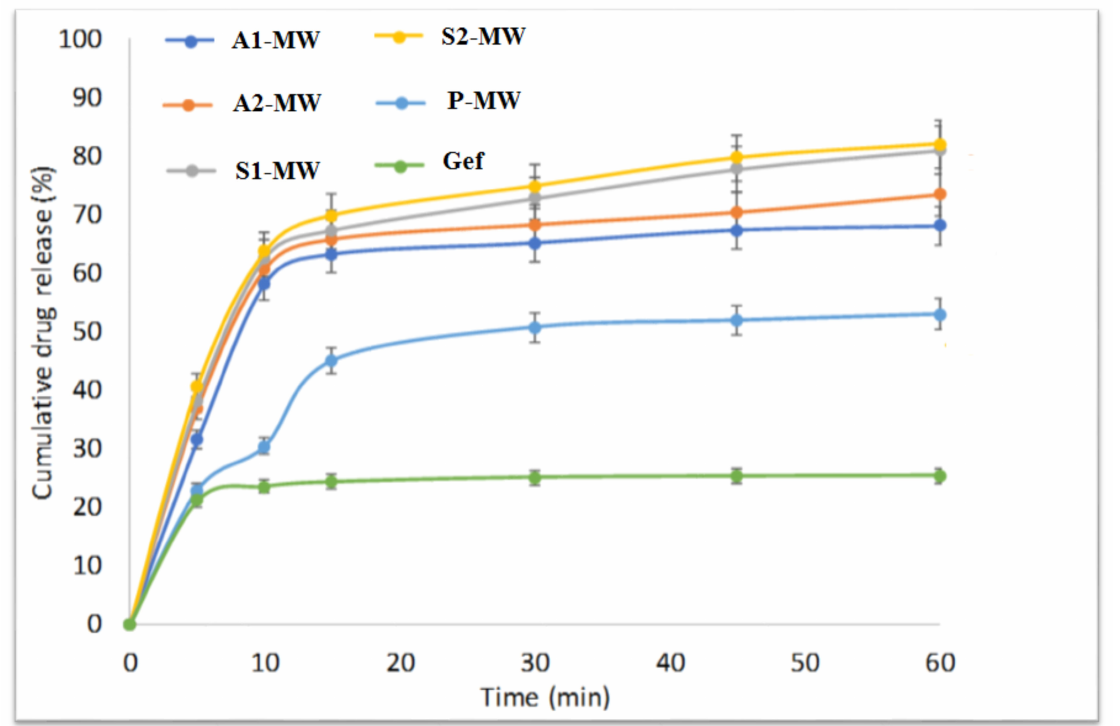
Figure 10. In vitro dissolution profile of Gef from pure Gef and various SDs prepared using microwave method (mean ± SD, n =